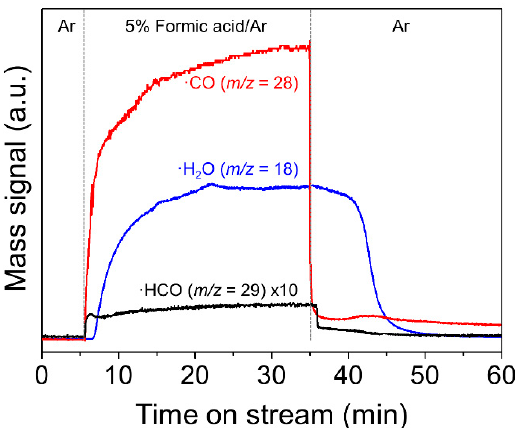
Figure 9. Evolution of ∙ H 2 O ( m/z = 18), CO ( m/z = 28), and ∙ HCO ( m/z = 29) in mass spectra as a function of time on stream over 10SZ(600) catalyst during formic acid on–off cycle test at 260 °C and 6.0 h − 1 WHSV.